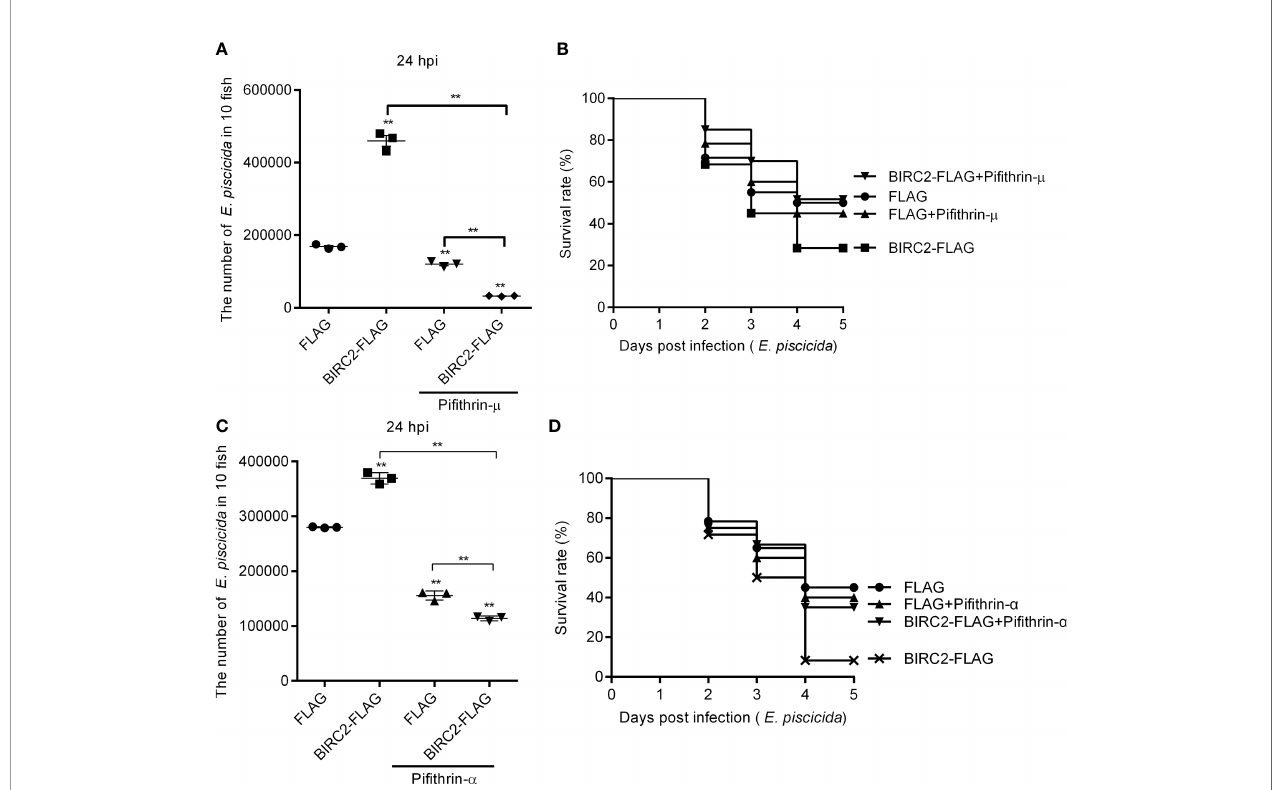
FIGURE 8 | The p53 inactivators block the negative regulation of zebra fi sh BIRC2 on the E. piscicida infection. (A) Pi fi thrin- m inhibited the zebra fi sh BIRC2-mediated bacterial proliferation at 24 hpi. (B) The effect of Pi fi thrin- m on the survival rates of zebra fi sh larvae microinjected with p3×FLAG or BIRC2-FLAG in the case of E. piscicida infection. (C) Pi fi thrin- a inhibited the zebra fi sh BIRC2-mediated bacterial proliferation at 24 hpi. (D) The effect of Pi fi thrin- a on the survival rates of zebra fi sh larvae microinjected with p3×FLAG or BIRC2-FLAG in the case of E. piscicida infection. For (A – D) , 4 dpf larvae microinjected with the p3×FLAG or BIRC2-FLAG were treated by adding Pi fi thrin- m or Pi fi thrin- a for 12 h, and then infected with E . piscicida . For (A, C) , larvae were collected at 24 hpi, and used for colony count. Data represented the means ± the SEM (n = 3) and were tested for statistical signi fi cance using a two-tailed student ’ s t -test. ** p < 0.01. The asterisk above the error bars indicates statistical signi fi cance using the group microinjected with empty plasmid and without treatment as the control group. The asterisk above the bracket indicates statistical signi fi cance between the two groups connected by the bracket. For (B, D) , larvae were monitored for 5 days. Exposures were performed in triplicate with 20 larvae per repetition (n = 60). Statistical differences using the log-rank test were observed between the FLAG/BIRC2-FLAG groups ( p < 0.05), BIRC2-FLAG/BIRC2-FLAG+ Pi fi thrin- m groups ( p < 0.01), and BIRC2-FLAG/BIRC2-FLAG+ Pi fi thrin- a groups ( p <